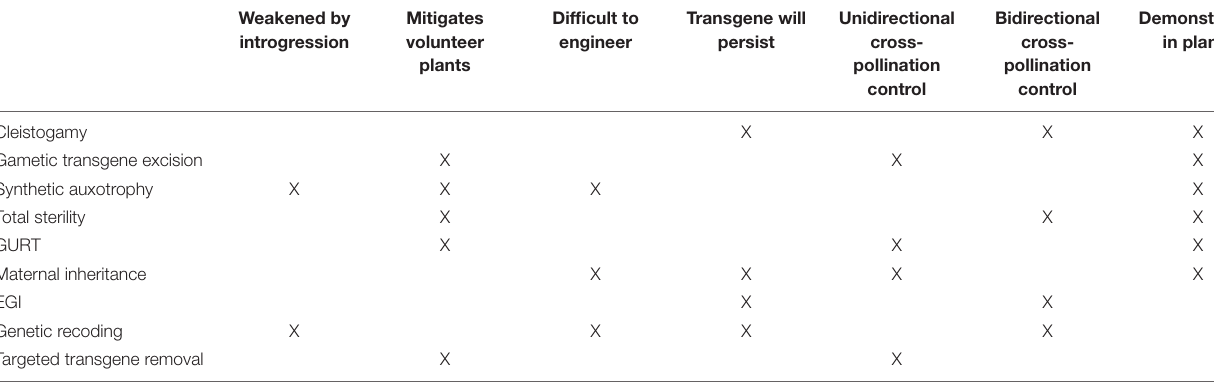
TABLE 2 | The important features of genetic biocontainment